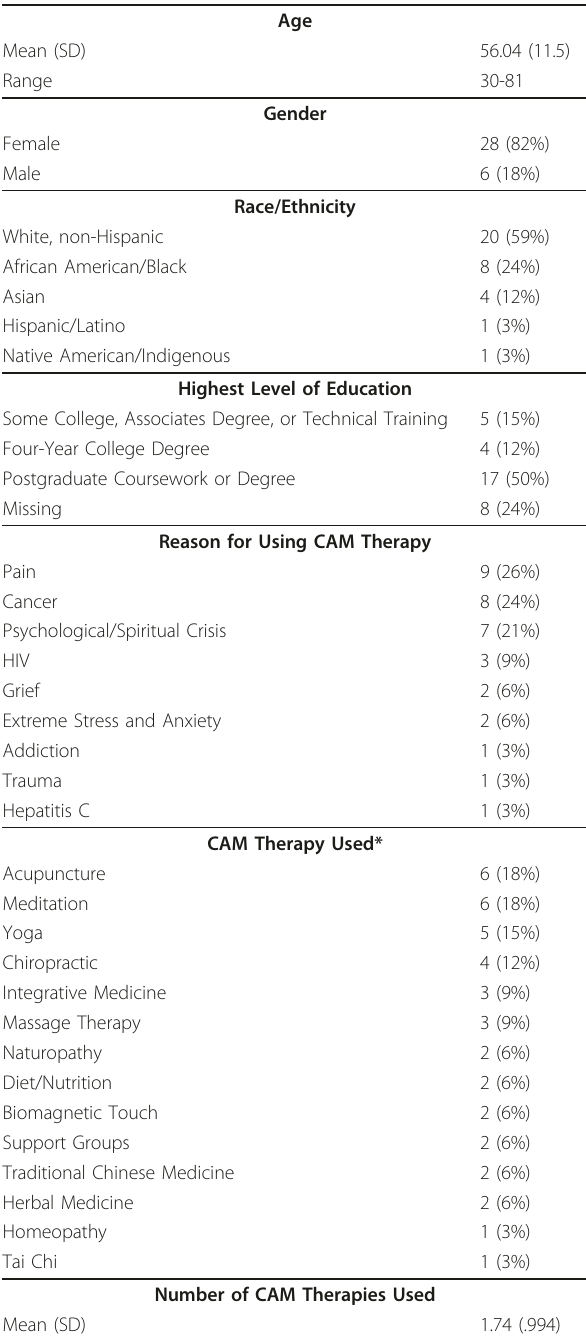
Table 5 Characteristics of Participants in Evocative Card Sort Interviews, Phase